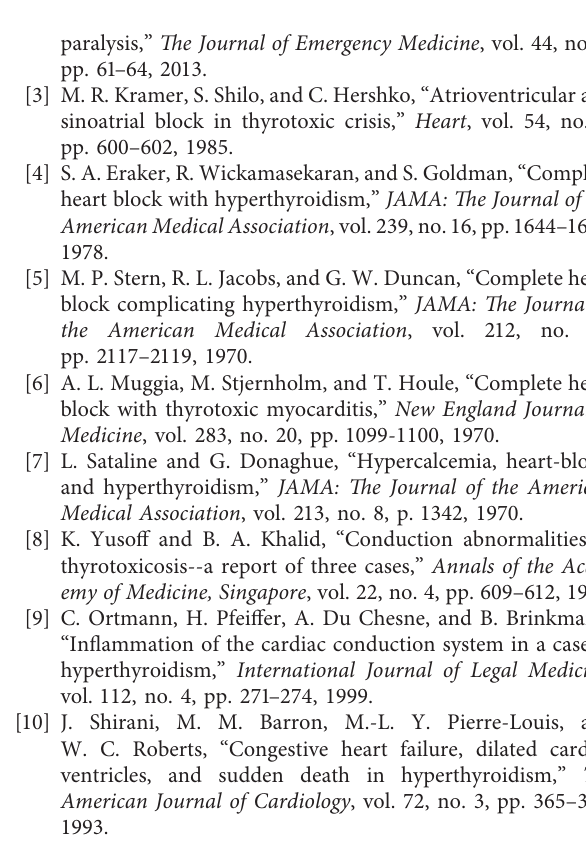
Figure 3: 8-day follow-up electrocardiography after decreasing the level of free T4 and T3 with propylthiouracil showing sinus